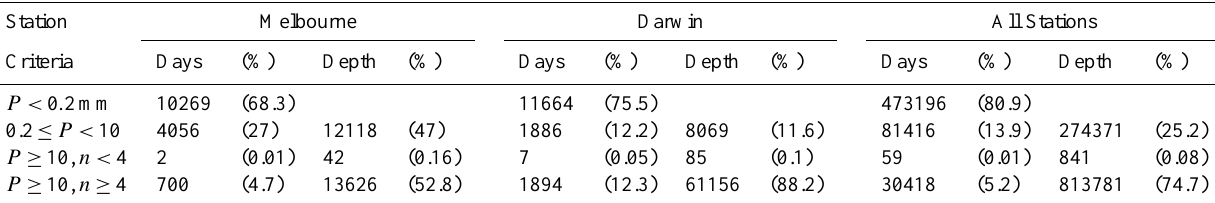
Table 2. Summary of data divided into categories based on daily total rainfall depth ( P ) and the number of 6 min periods ( n ) where rainfall intensity exceeded the threshold (1mmh − 1 ). The number of days and daily rainfall depth (mm) are listed for the stations in Melbourne and Darwin individually, and for all stations